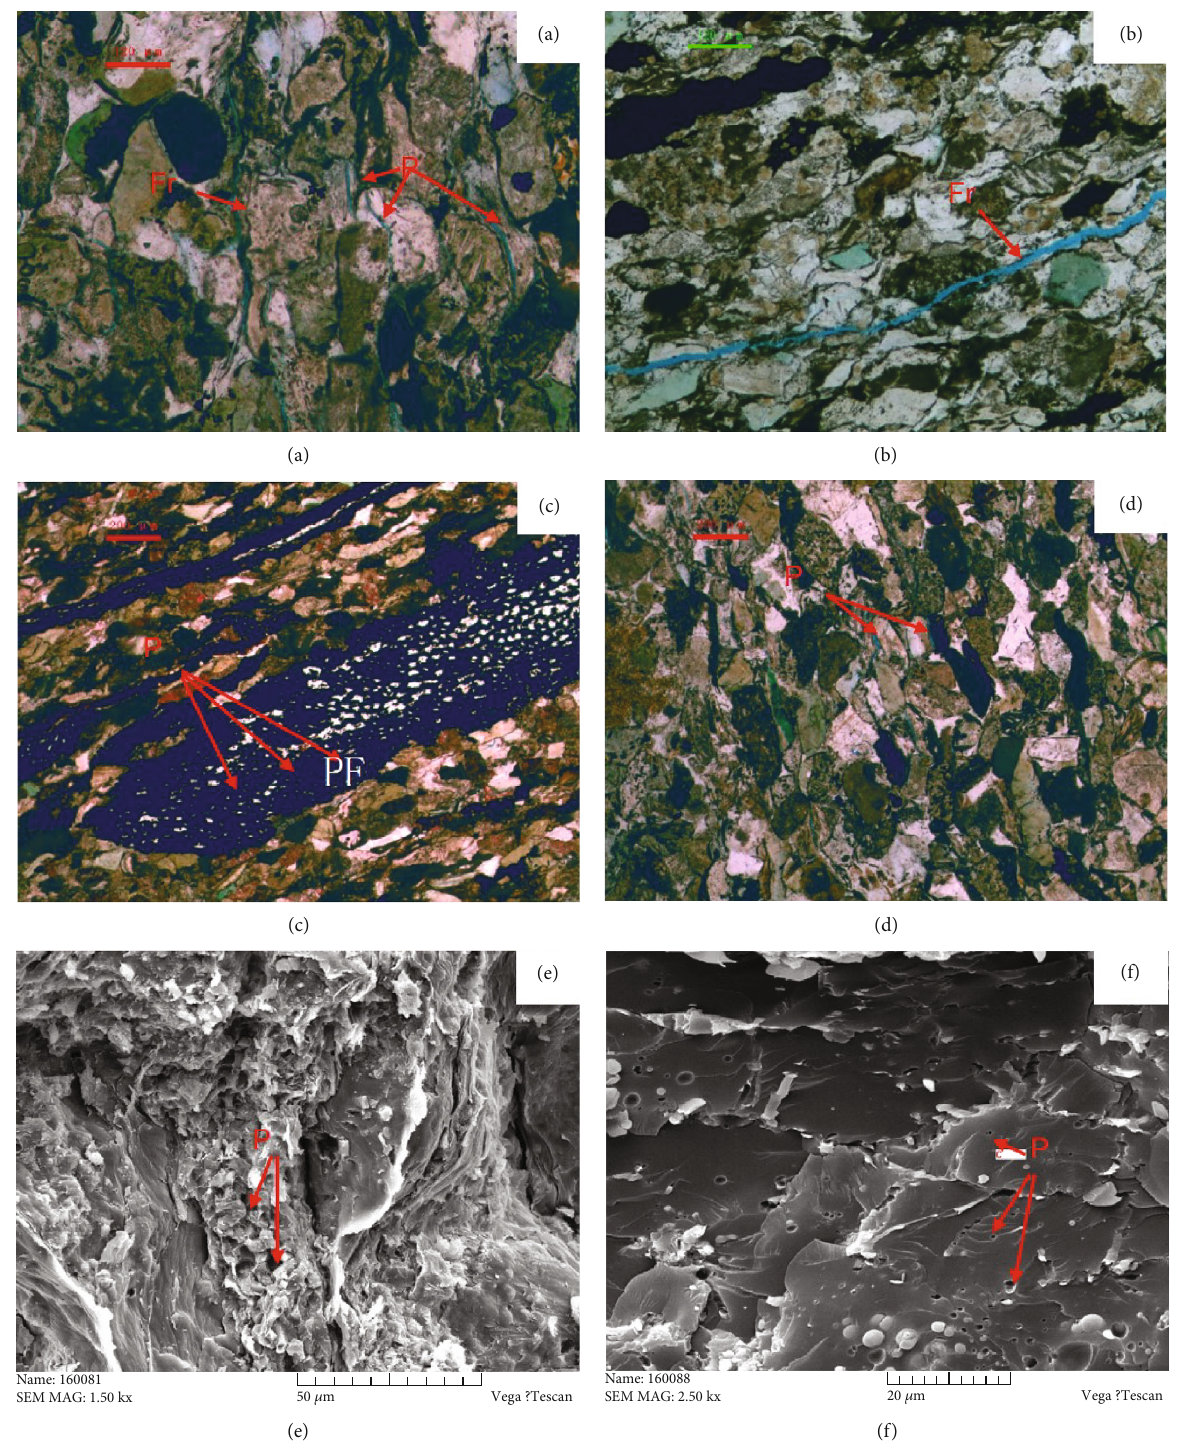
Figure 5: Photomicrographs showing pores and microfractures within the Longtan sandstones. (a) Intrapores ( P ) within feldspar and developed microfracture ( Fr ), YV-1-1, 810.85m, Longtan Formation, and polarized light; (b) a microfracture ( Fr ) is present, HV-3-1, 888.3, Longtan Formation, and polarized light; (c) intergranular micropores ( P ) are observed in plant fragments (PF) , YV-1-3, 681.11m, Longtan Formation, and polarized light; (d) intergranular macropores ( P ) are present within grains, YV-1-1, 810.85m, Longtan Formation, and polarized light; (e) micropores ( P ) are mainly associated with clay minerals which display fi brous and fl ake-like structure, YV-1-2, 769.6m, Longtan Formation, and SEM; (f) organic micropores ( P ) are seen in this sandstone, YV-1-3, 681.11m, Longtan Formation, and